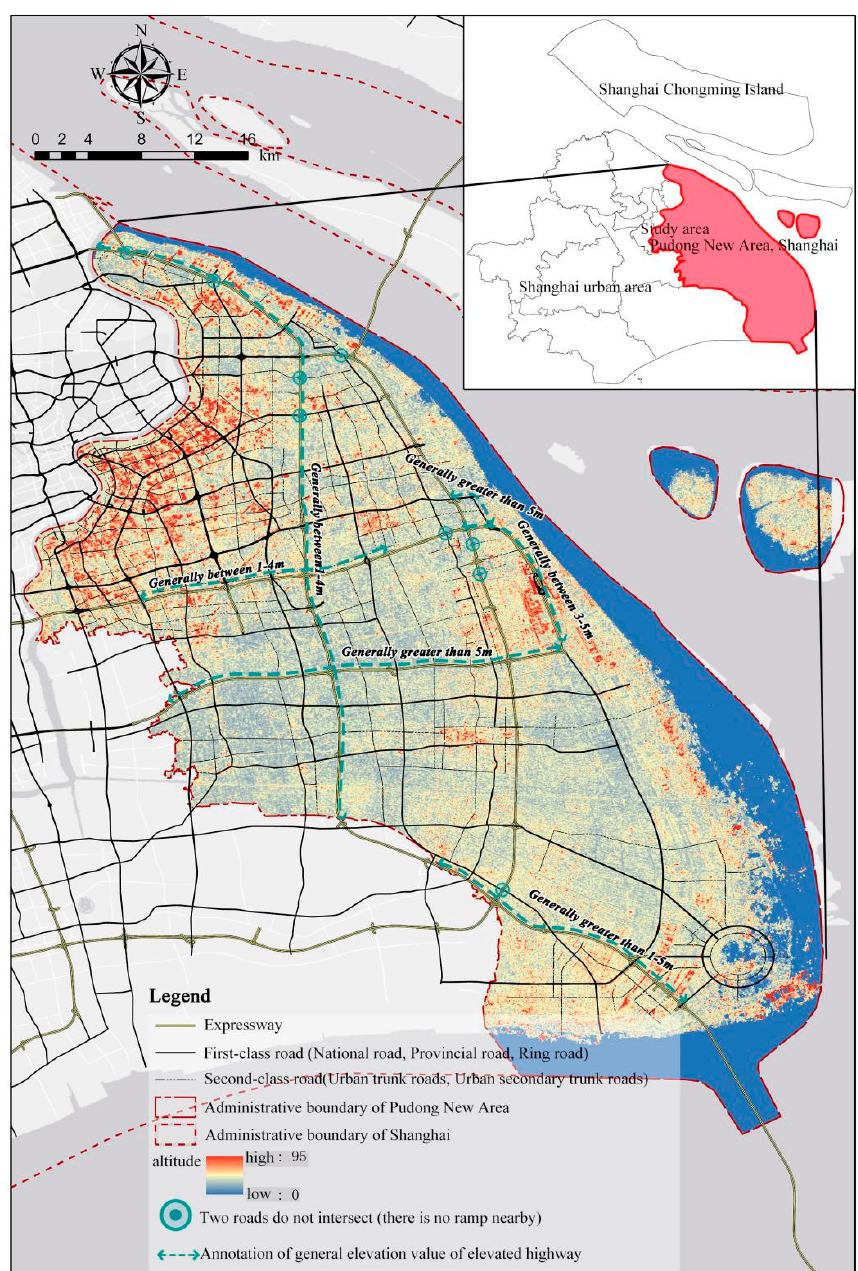
Figure 1. The study area and elevation map (Source: self-drawn by the author, map from the following link: http://www.gscloud.cn/, accessed on 1 February 2022).